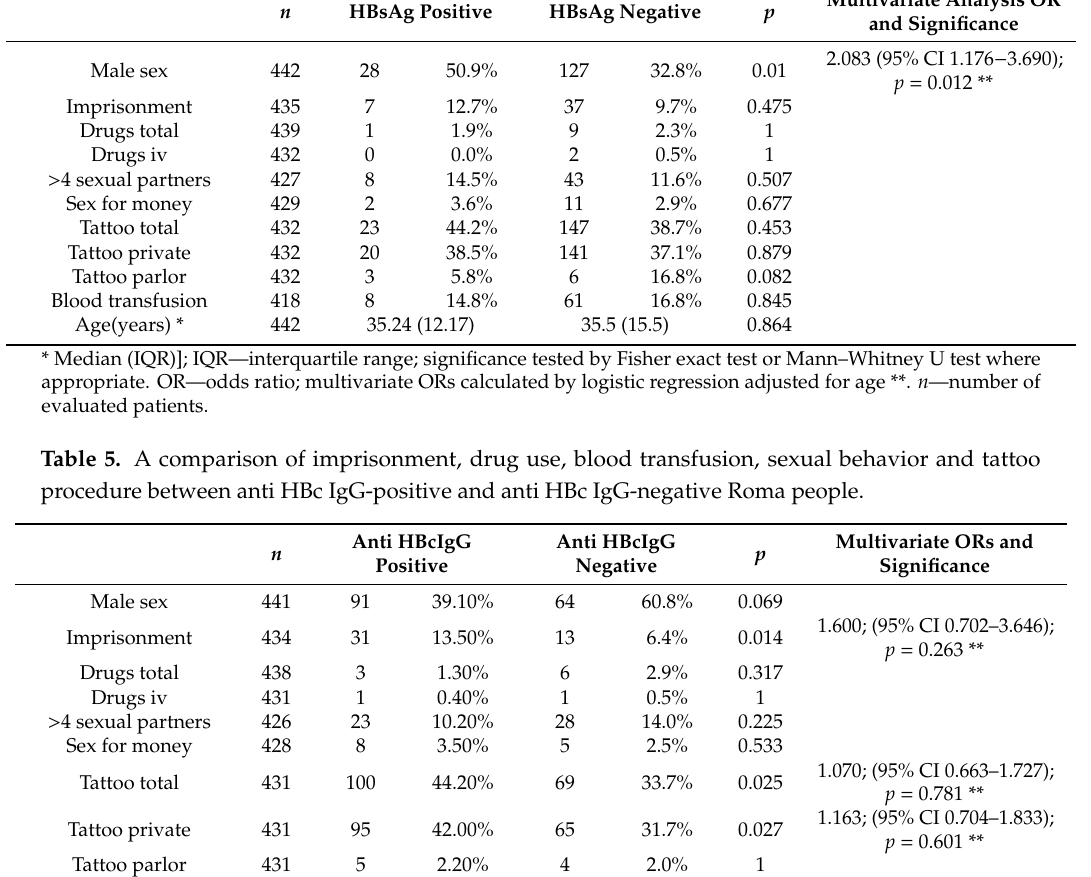
Multivariate Analysis OR and Significance